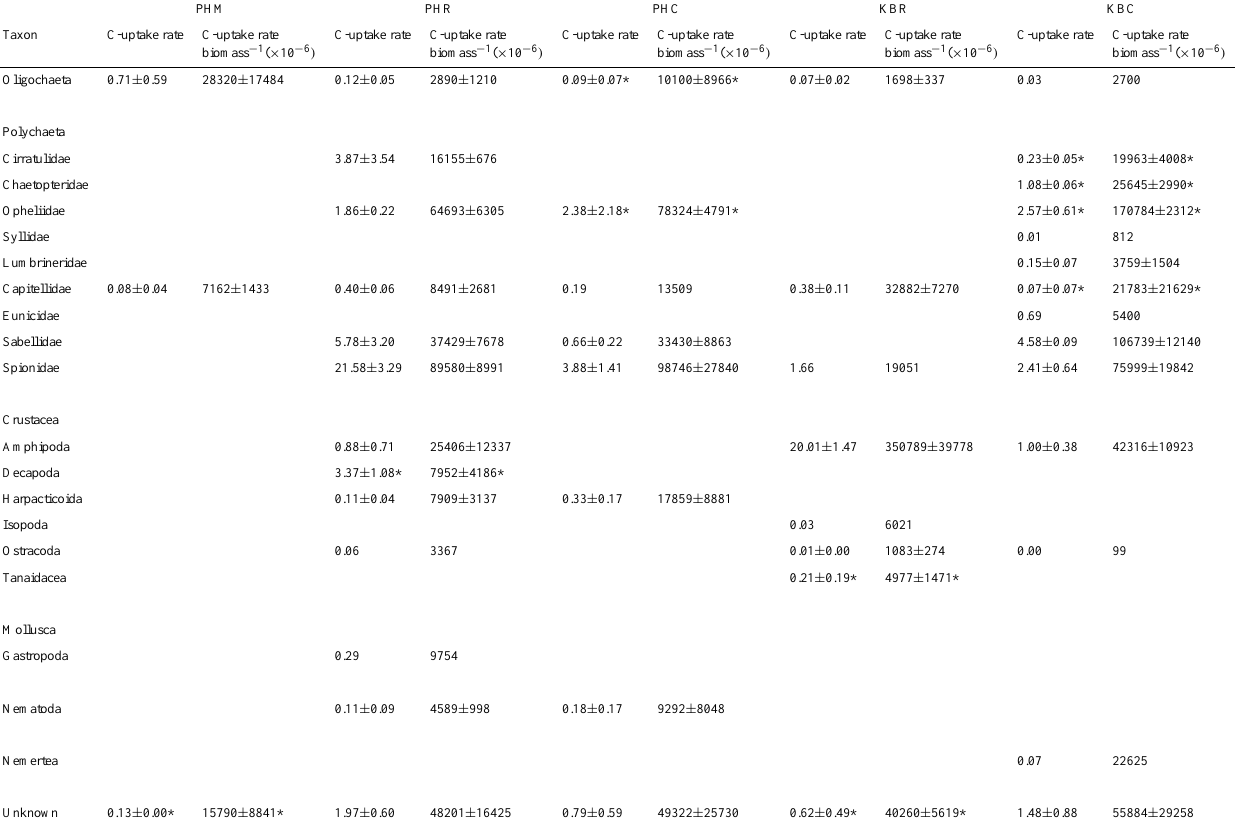
Table 4. Mean C-uptake rate (mg g C − 1 m − 2 d − 1 ± 1SE, n = 3) and mean C-uptake rate normalized to biomass (mg g C − 1 m − 2 d − 1 mg C biomass − 1 ± 1SE, n = 3) of major macrofauna taxa from sediments collected from all 5 sites. Star ( ∗ ) denotes mean ± range of 2 samples when only 2 replicate chambers contained a specific taxon for C-uptake